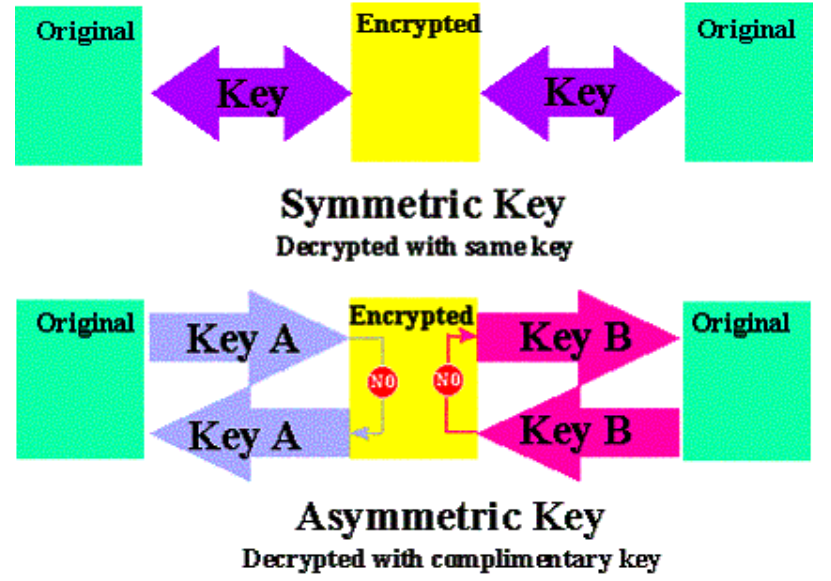
Figure 2 Symmetric and asymmetric encryption keys (Telleen,